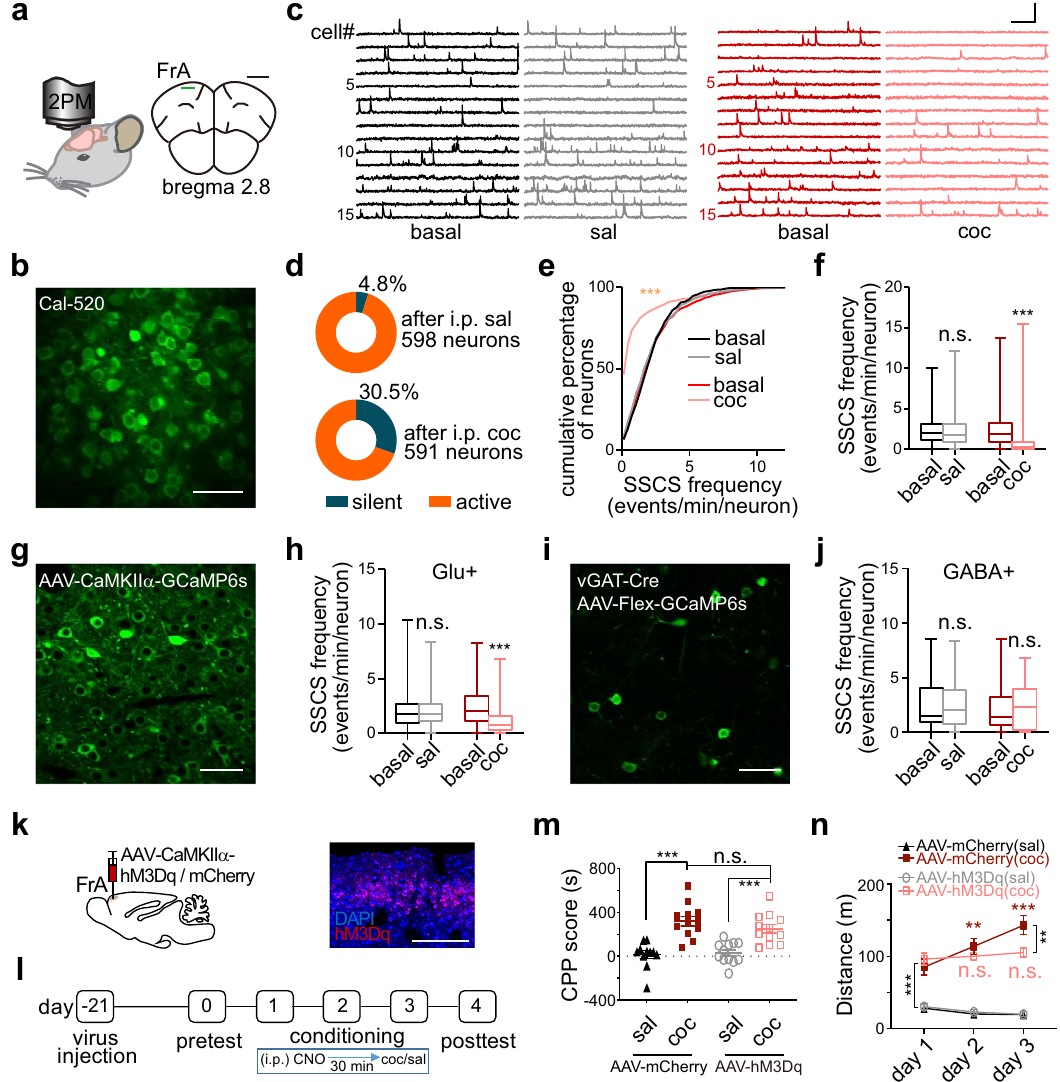
Fig. 1 | Acute cocaine-induced hypoactivity of the FrA is necessary for loco- motorsensitization. a , b Schematic and representative micrograph showing two- photon Ca 2+ imaging of Cal-520-labeled neurons in the FrA of head- fi xed awake mice. Scale bars: 1mm ( a ) and 50 µ m ( b ). c Representative traces of spontaneous somatic Ca 2+ signals (SSCS) before (basal) and after i.p. injection of saline (sal) or cocaine (coc,10mg/kg). Scalebars, 20s,200% dF/F 0 . d Percentageof silentversus active cells after saline or cocaine injection. e , f Cumulative distribution and box- and-whisker plot (minimum, maximum, and three quartiles) of SSCS frequency under different conditions. Sal, n =598 neurons from seven mice ( p =0.28); coc, n =591 neurons from seven mice. g , h Representative micrograph and statistics (minimum,maximum,andthreequartiles)ofSSCSfrequencyofexcitatoryneurons in the FrA before and after i.p. saline or cocaine. Scale bar, 50 µ m. Sal, n =185 neurons from four mice ( p =0.63); coc, n =227 neurons from fi ve mice. i , j Representative micrograph and statistics (minimum, maximum, and three